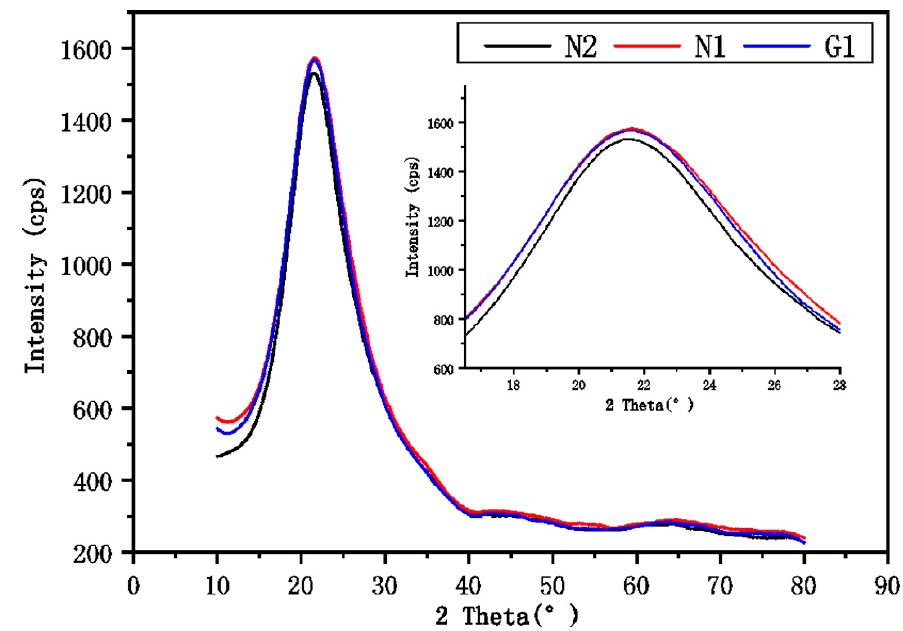
Figure 1. XRD patterns of the Inner Mongolia autonomous region and treated by acid (N1), Inner Mongolia autonomous region and used without acid treatment (N2), and Guangdong province treated by acid (G1) rice husk ash (RHA) samples.